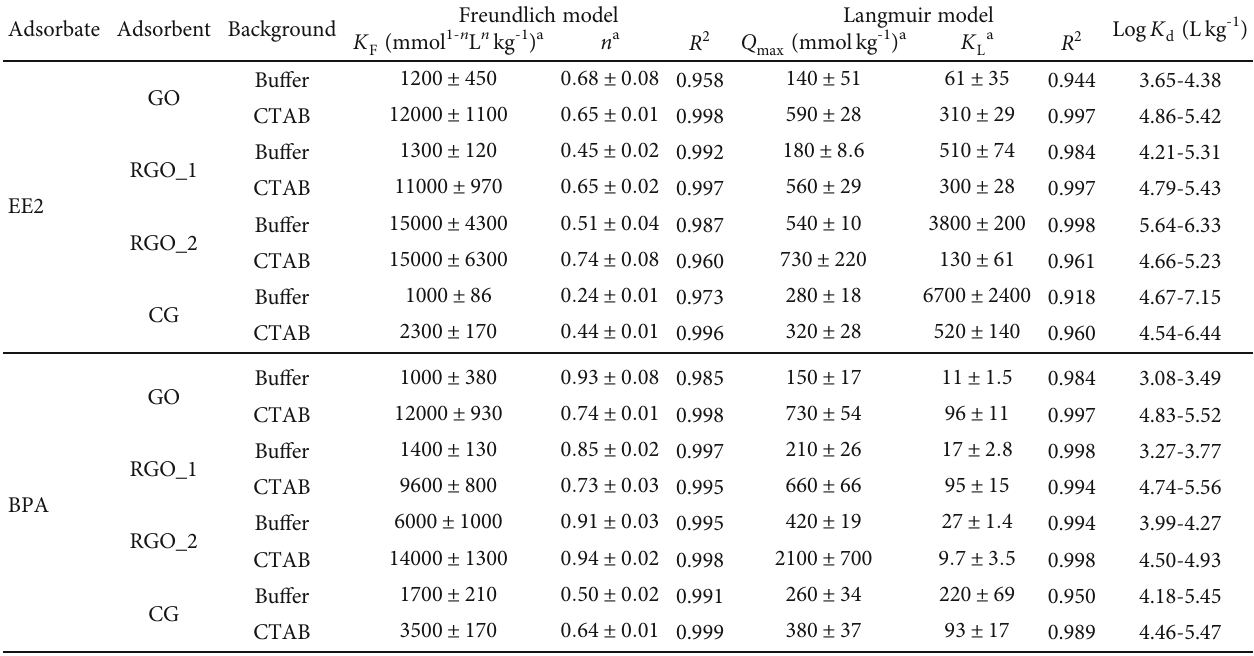
and n ) and distribution coe ffi cients ( K F